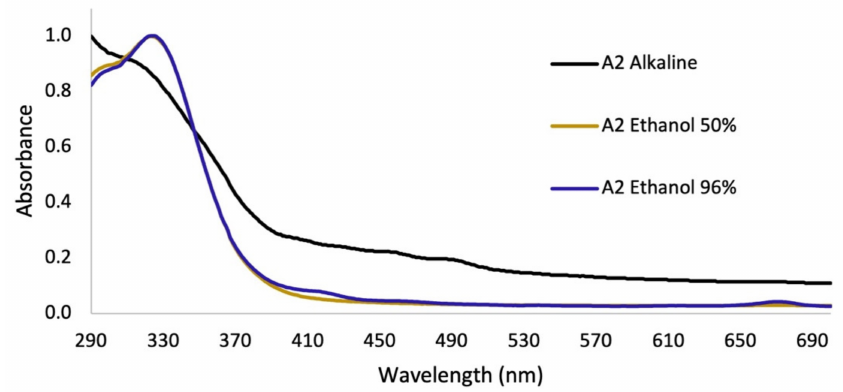
Figure 4. UV–Vis absorption spectra for extractions of B. antioquensis Assay 2.